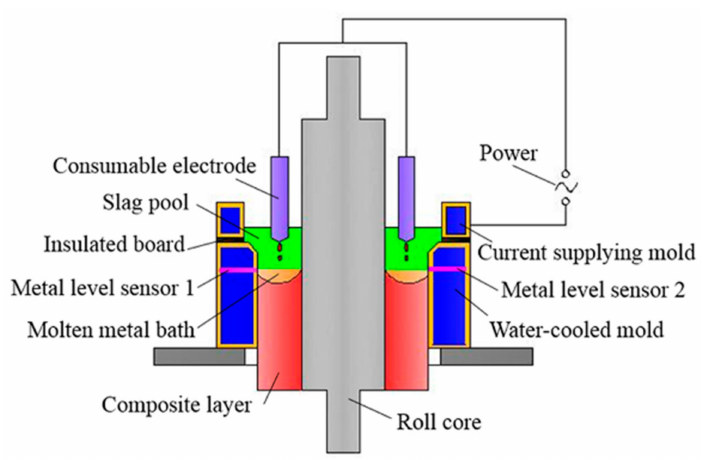
Figure 1. Schematic diagram of the new improved electroslag cladding method.